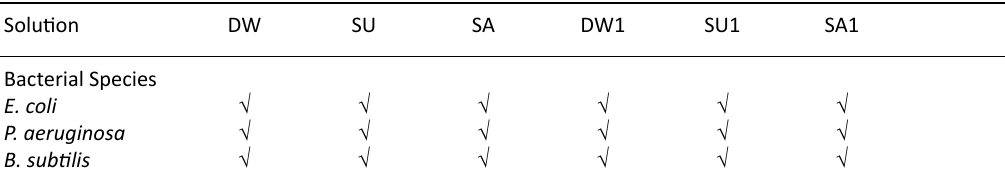
table 1. Isolation of bacterial species from different solutions after dipping and removal of M. domestica immediately and one hour later Solution DW SU SA DW1 SU1 SA1 Bacterial Species E. coli √ √ √ √ √ √ P. aeruginosa √ √ √ √ √ √ B. subtilis √ √ √ √ √ √